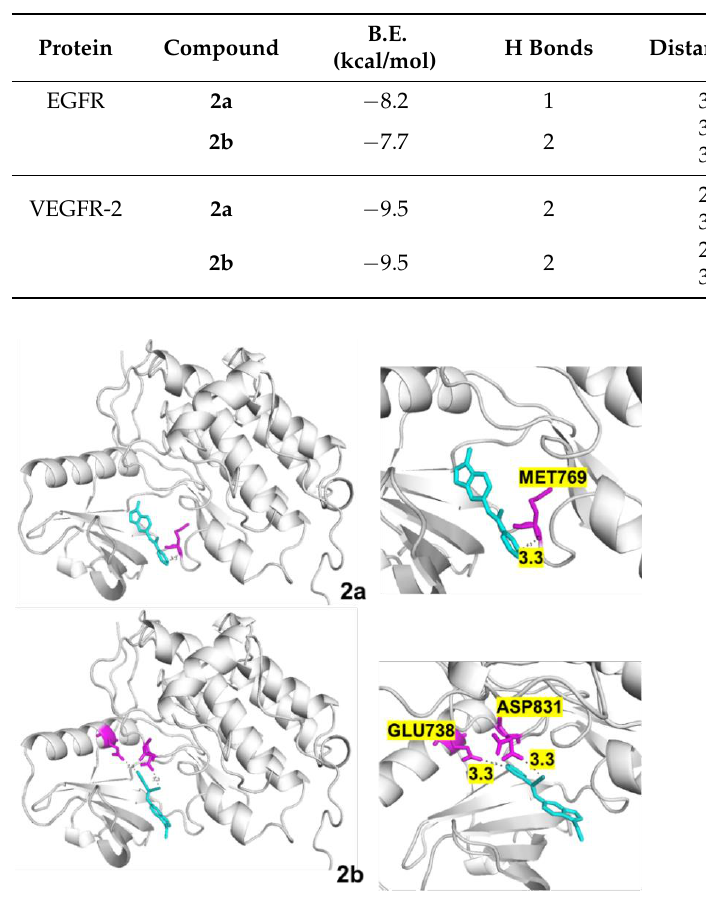
Figure 11. Molecular docking of 2a and 2b into EGFR.